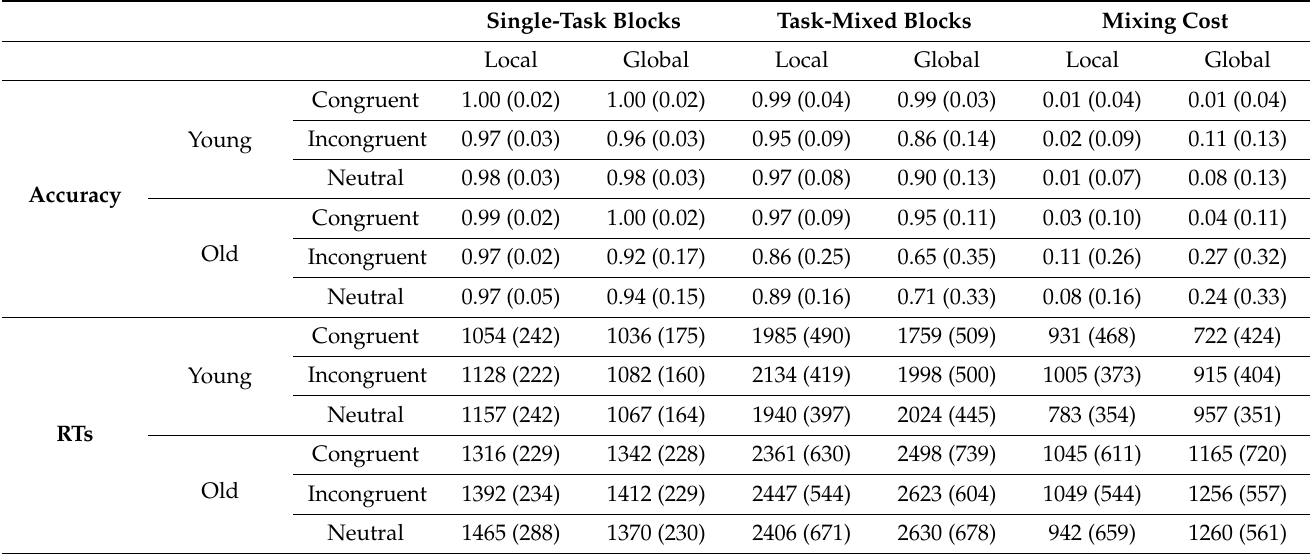
Table 1. Means and standard deviations for single-task blocks, task-mixed blocks, and mixing cost in accuracy (proportion) and reaction times (in milliseconds) on the global–local task, as a function of group, condition and